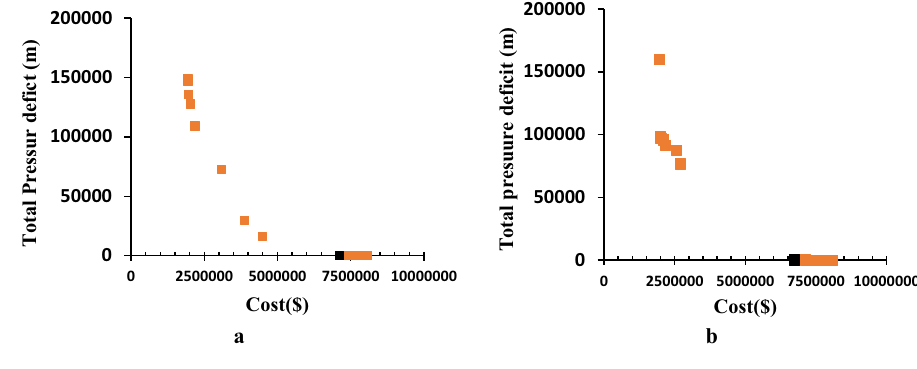
Fig. 6 Front of non-dominated solutions of three-loop WDN: a. variable leakage and b . constant leakage